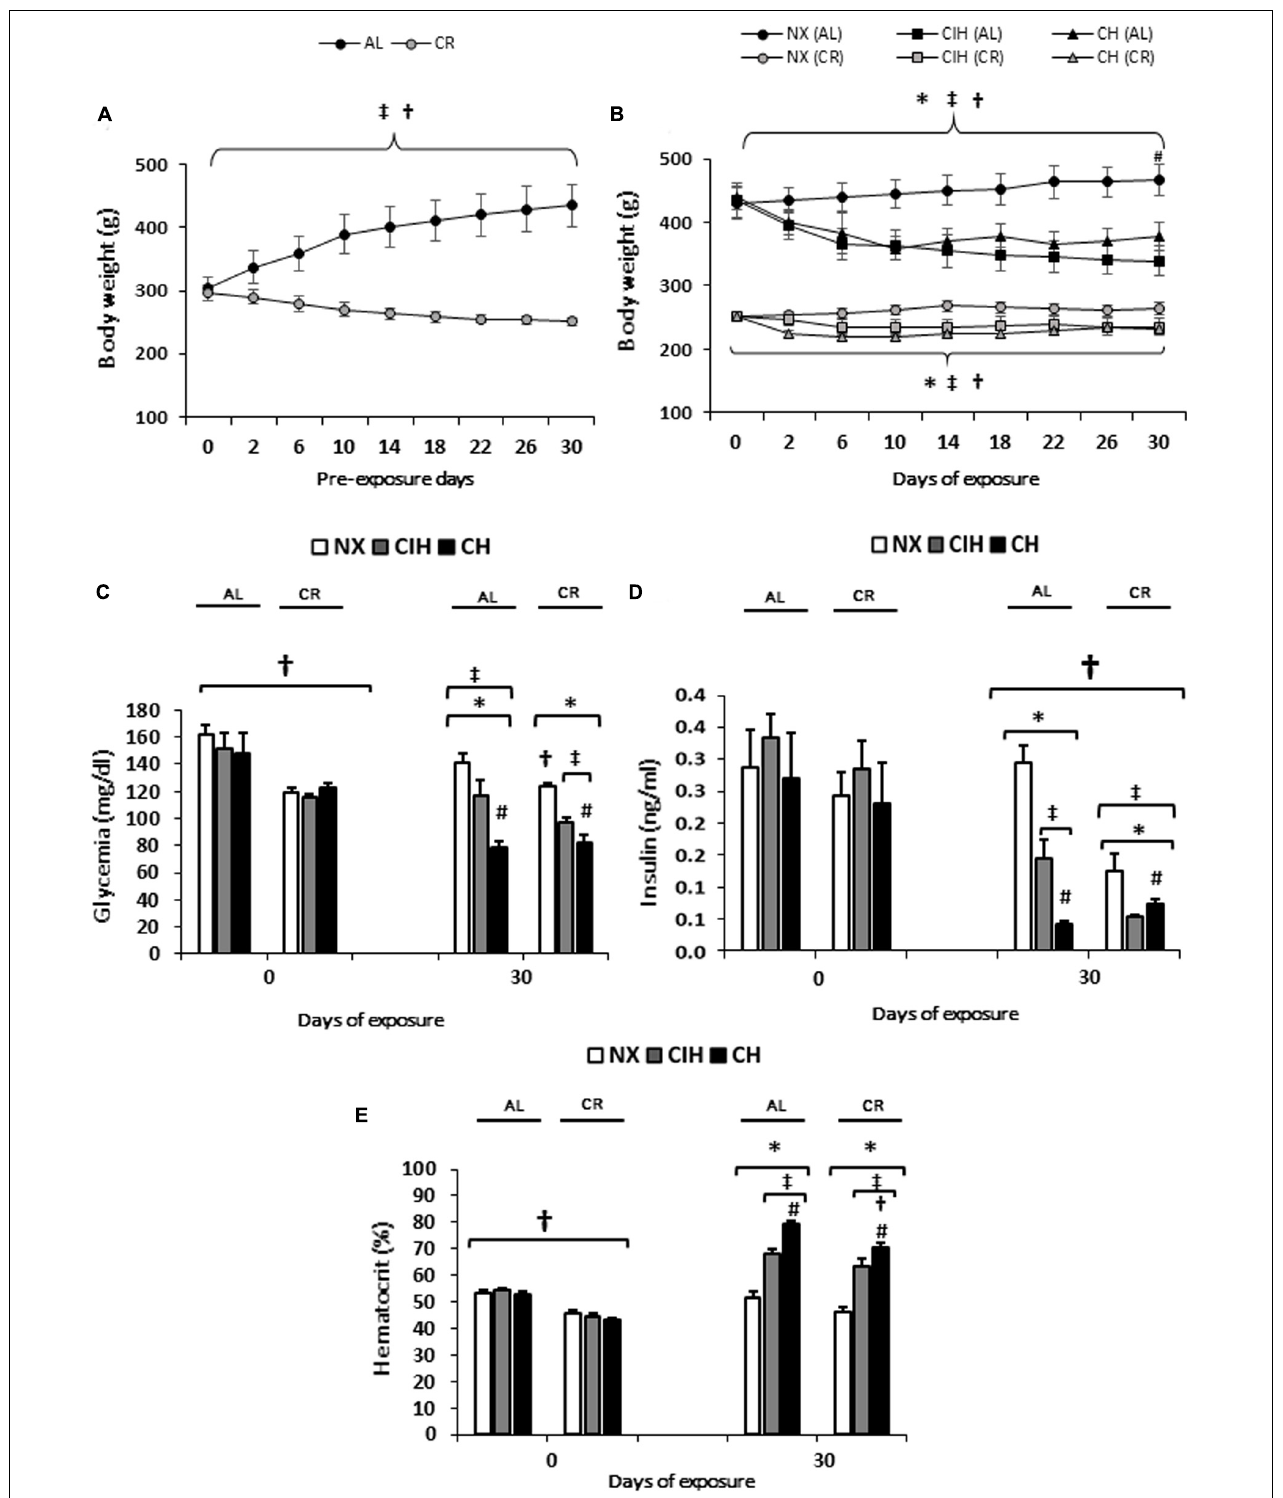
FIGURE 1 | Physiological and biochemical parameters: Ad libitum (AL) and caloric restriction (CR) groups on days 0 and 30: normoxic group (NX), chronic intermittent hypoxia group (CIH), and chronic hypoxia group (CH). (A) Body weight (g) previous to exposure, (B) Body weight (g) during exposure, (C) Blood glucose (mg/dl) and (D) Serum insulin (ng/ml) (E) Hematocrit (%). The values are the mean ( ¯ x) ± standard error (SE). ∗ p < 0.05: hypoxia-exposed vs. NX; # p < 0.05: CIH vs. CH. † p < 0.05: AL vs. CR; ‡ Day 30 vs. Day 0 for each group NX, CIH and CH of AL and CR groups.